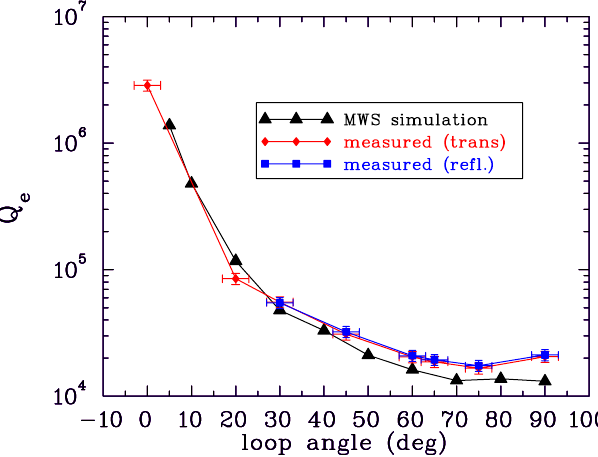
FIG. 15. (Color) Comparison between measurement and simu- lation of the external Q -value as a function of the position of the capacitive